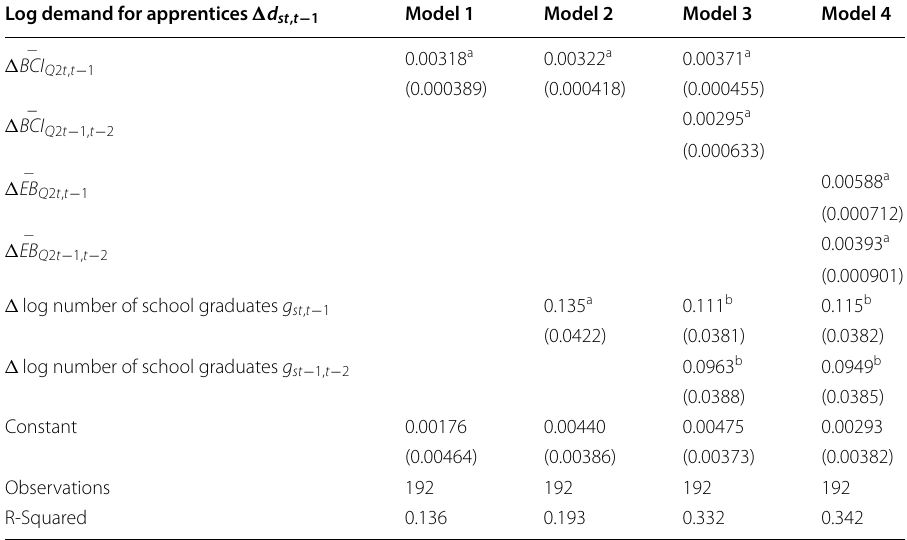
Heteroskedasticity and autocorrelation‑robust standard errors in parentheses. a Significant at the 1%‑level; b significant at the 5%‑level; c significant at the 10%‑level. Data sources: Federal Employment Agency and BIBB‑Survey of new apprenticeship contracts as of 30 September; ifo Business Climate Index and ifo Employment Barometer